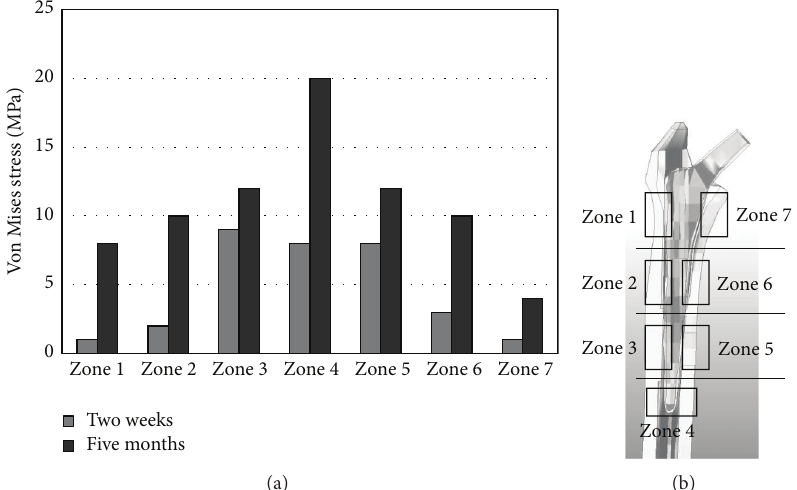
Figure 5: Von Mises stress analyzed by finite element methods. (a) Von Mises stress values in each zone 2 weeks and 5 months after the operation. (b) Finite element model and Gruen’s zone